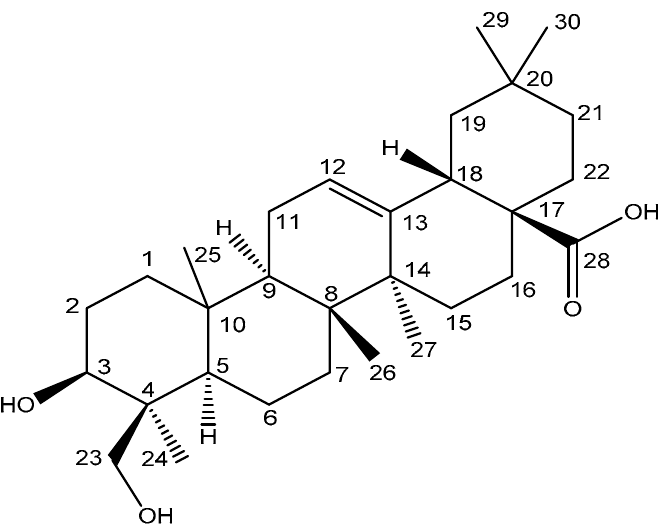
Figure 4. Chemical structure of the metabolite (M1) from OA. The OH group at position C-23 shows the structure of the metabolite as 4-epi-hederagenin.